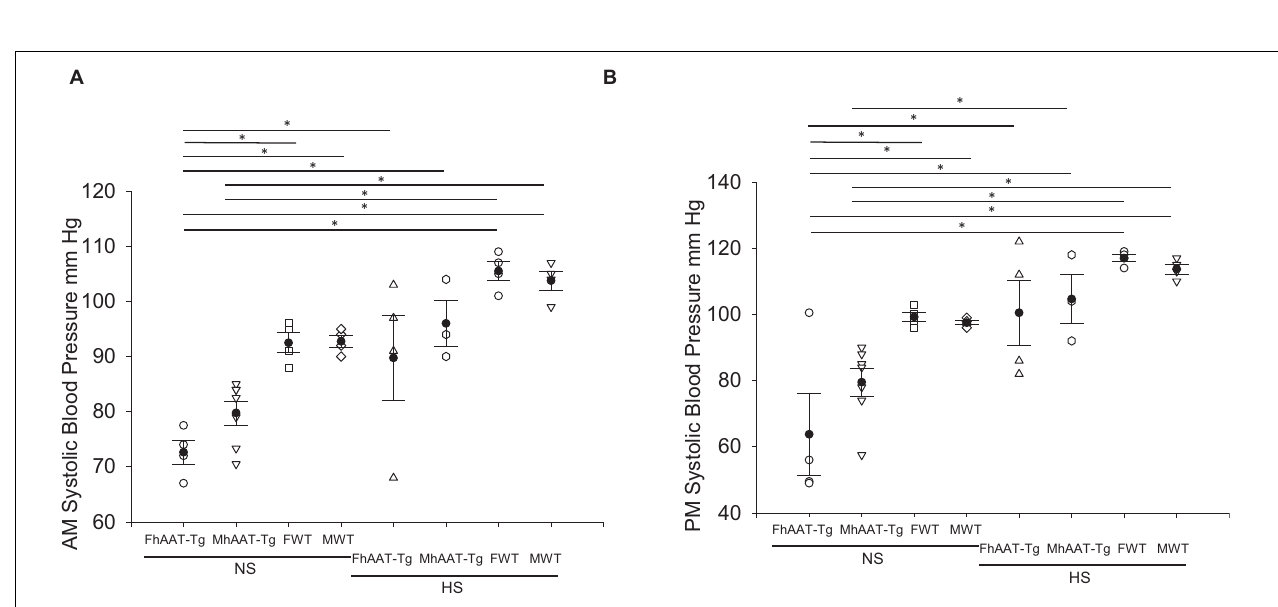
FIGURE 3 | Systolic blood pressure of male and female hAAT-Tg and C57B/6 wild-type mice maintained on a normal or high salt diet during the inactive and active cycles. (A) Tail cuff systolic blood pressure measurements during the inactive (AM) cycle for female and male hAAT-Tg mice and C57B/6 wild-type mice maintained on a normal salt (NS) or high salt (HS) diet. (B) Tail cuff systolic blood pressure measurements during the active (PM) cycle for female and male hAAT-Tg mice and C57B/6 wild-type mice maintained on a normal salt (NS) or high salt (HS) diet. N = 10 hAAT-Tg (4 female and 6 male) and N = 8 C57B6 (4 female and 4 male) mice. These results were analyzed using a One-Way ANOVA followed by a Holm-Sidak comparison. We used a significance level of * p < 0.05.